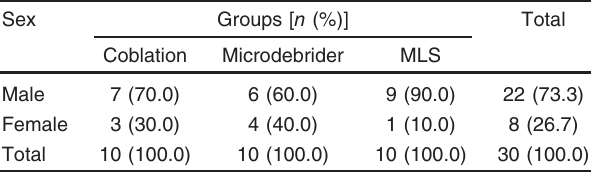
Table 1 Comparison between the three groups regarding